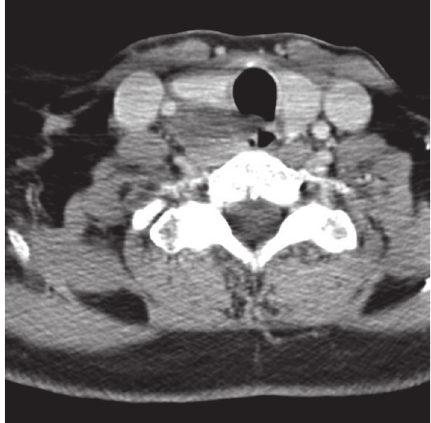
Figure 5: First CT scan of the neck after the initiation of pem- brolizumab, 4 doses (axial image).